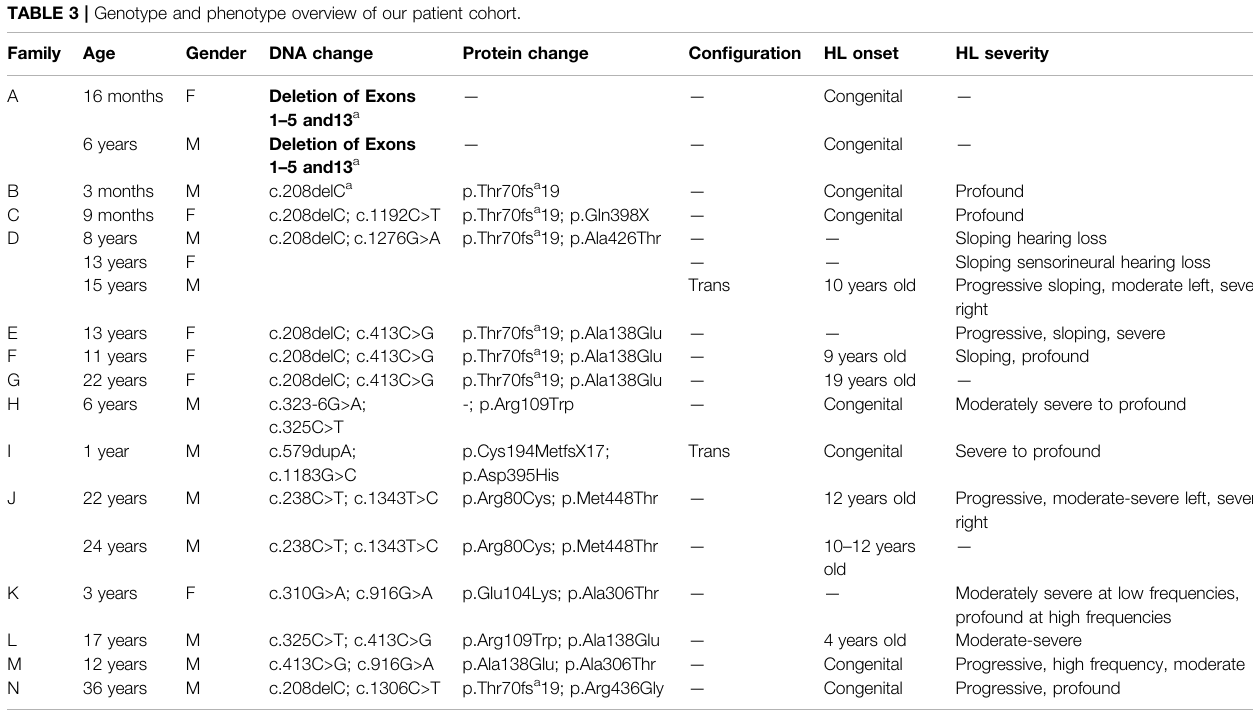
TABLE 3 | Genotype and phenotype overview of our patient